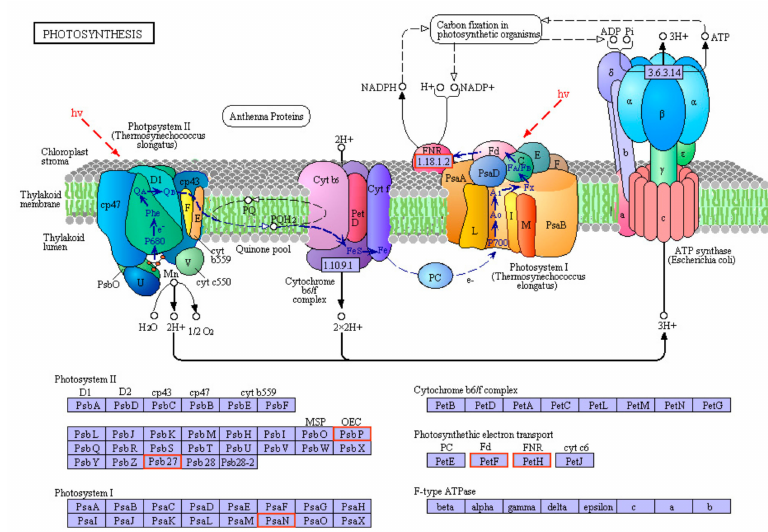
Figure 8. The metabolic pathway involved in photosynthesis. Definition of genes encoding proteins: (1) PsbP, photosystem II oxygen-evolving enhancer protein 2; (2) Psb27, photosystem II Psb27 protein; (3) PsaN, photosystem I subunit PsaN; (4) PetF, ferredoxin; (5) PetH, ferredoxin-NADP + reductase. Red boxes indicated an